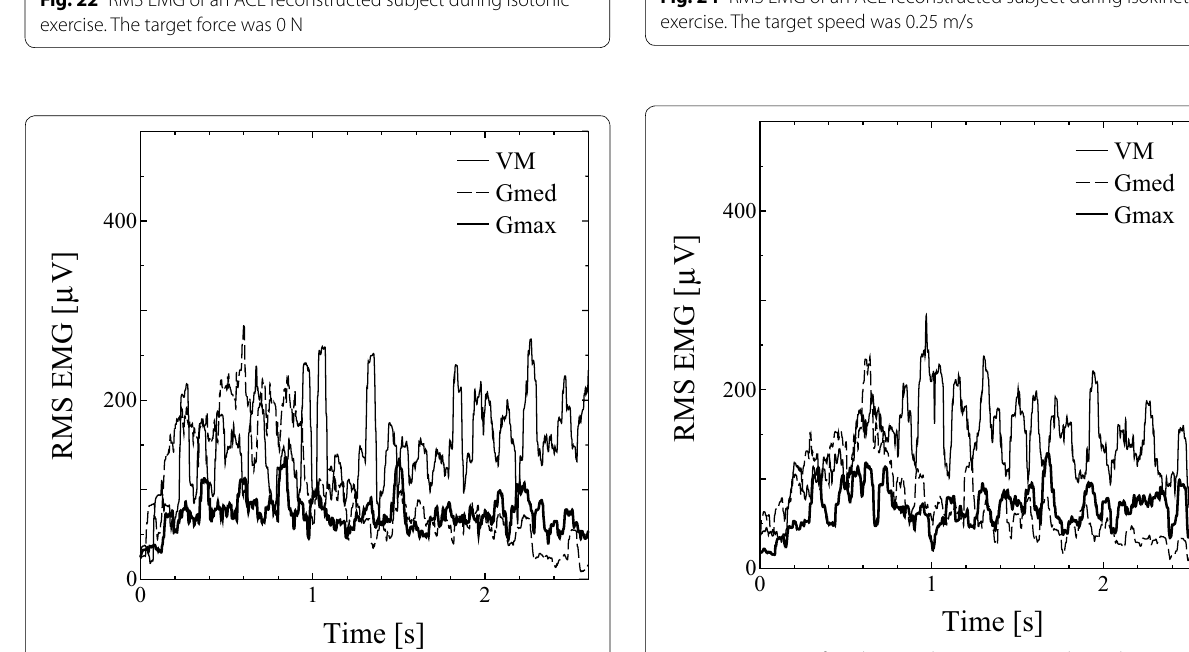
Fig. 25 RMS EMG of a subject with a reconstructed ACL during isotonic exercise. The target force was 80